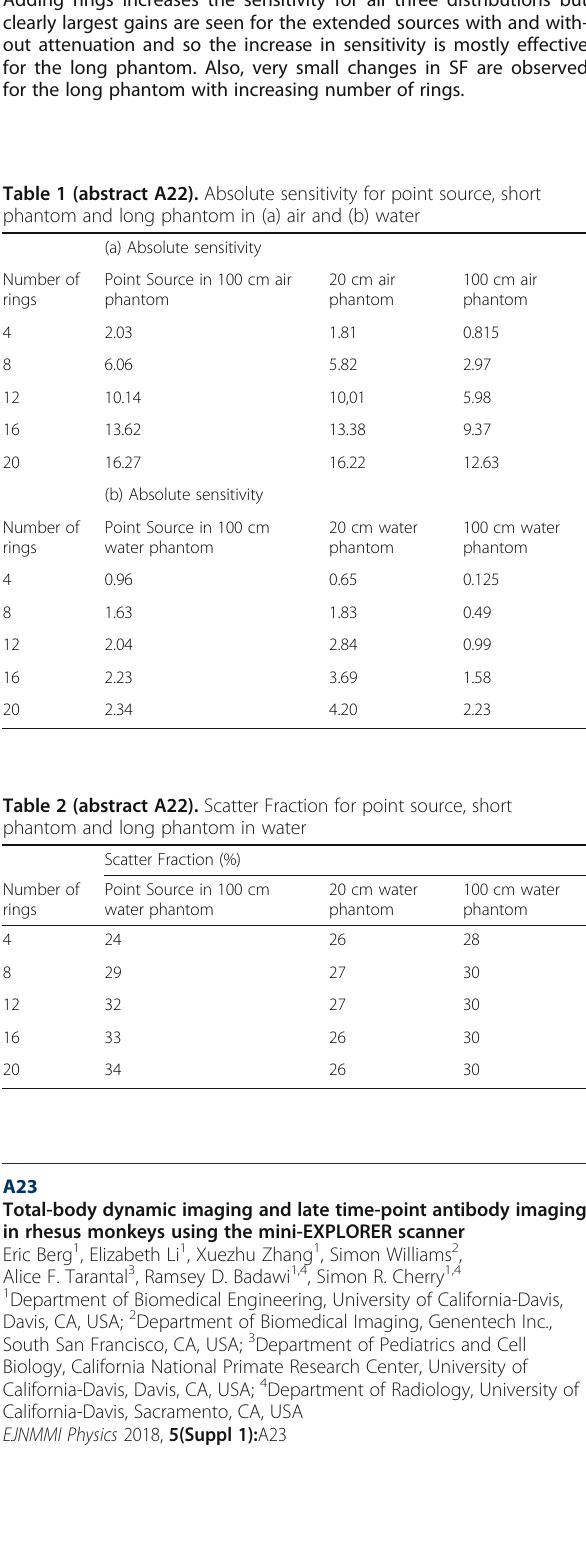
Conclusion Adding rings increases the sensitivity for all three distributions but clearly largest gains are seen for the extended sources with and with-